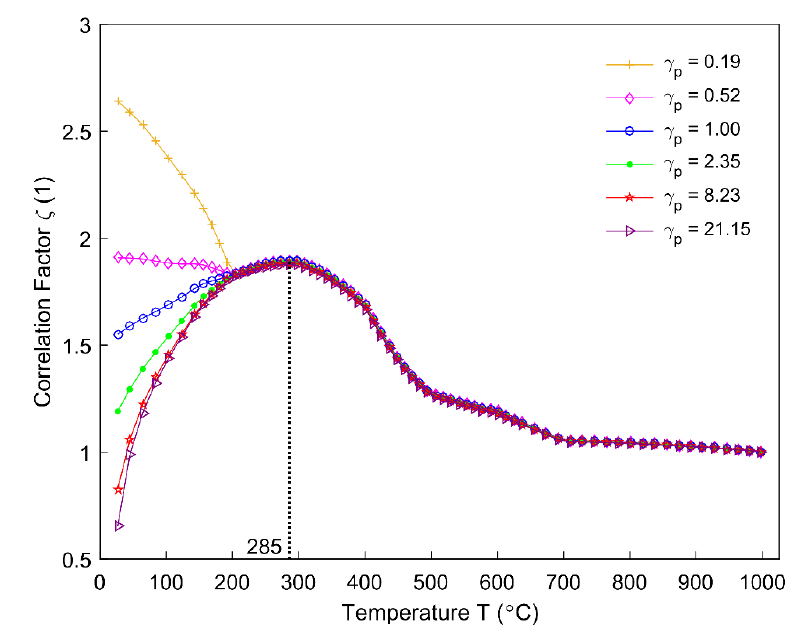
Figure 19. Correlation factor for different permeability correlators.